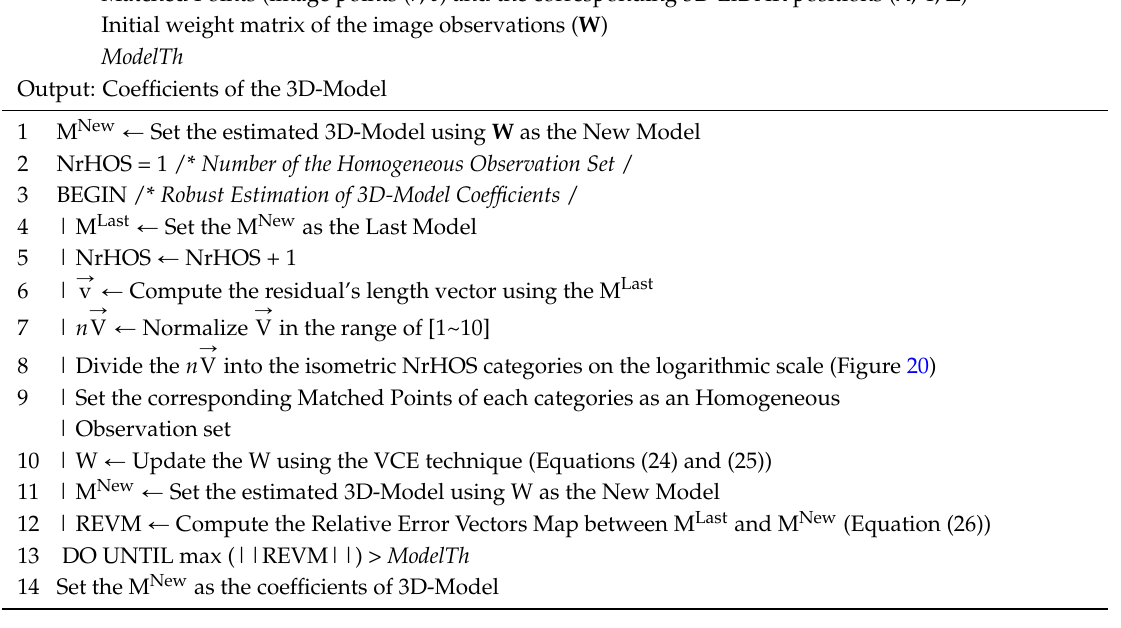
Algorithm 4 Robust Estimation of the 3D-Model